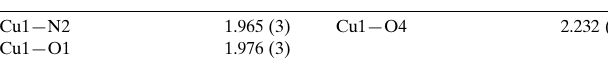
Selected bond lengths (A˚ ).